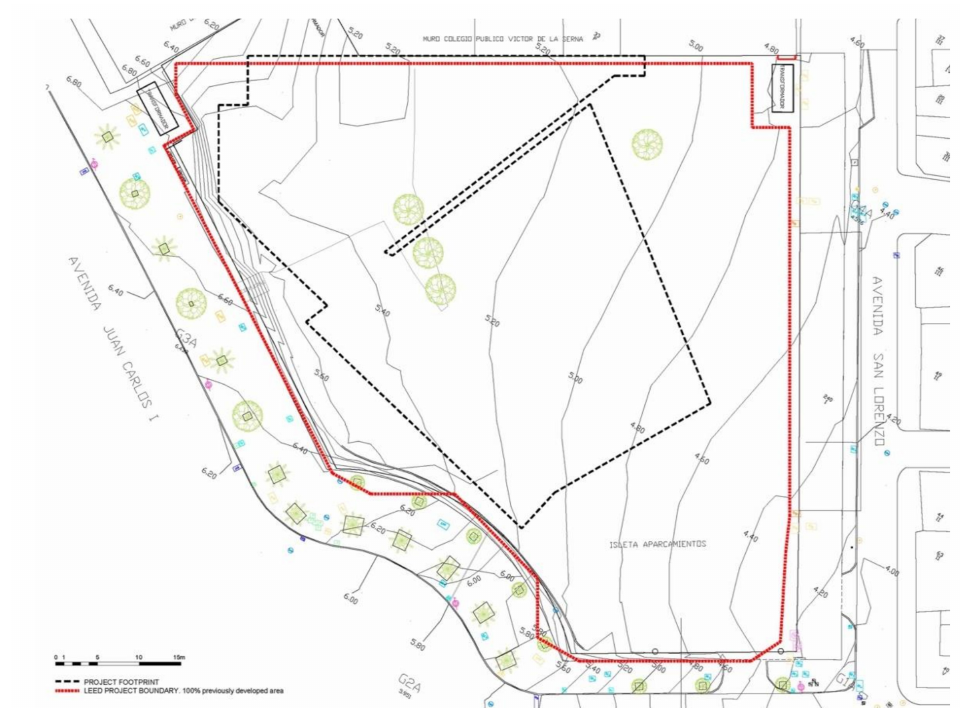
Figure 6. ( above ) Aerial view of Estepona town centre where the project is located. Combined density (m 2 /hectares) = Total floor area (m 2 )/Total buildable land (hectares) Combined density (m 2 /hectares) = 487,463.60/32.50 = 14,998.88 m 2 /hectares. ( middle ) View of the original state of the plot on which the current building is located. The boundary of the plot’s urban performance represented by a red line. ( below ) Location plan with the footprint of the building in relation to the plot in black dashed line. Source: Castaño & Associates. LEED Rating System Report